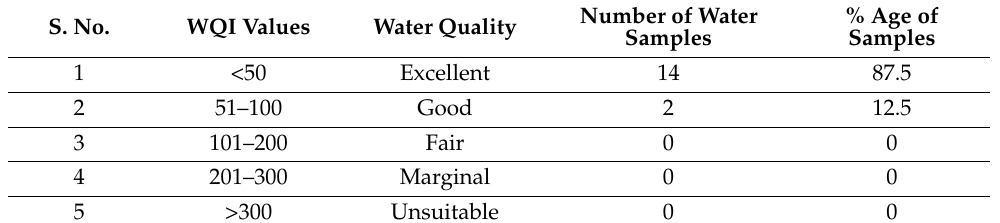
NA = Not Available (prescribed standards). Table 3. WQI range and water quality classification for drinking purposes in the study area. S. No.